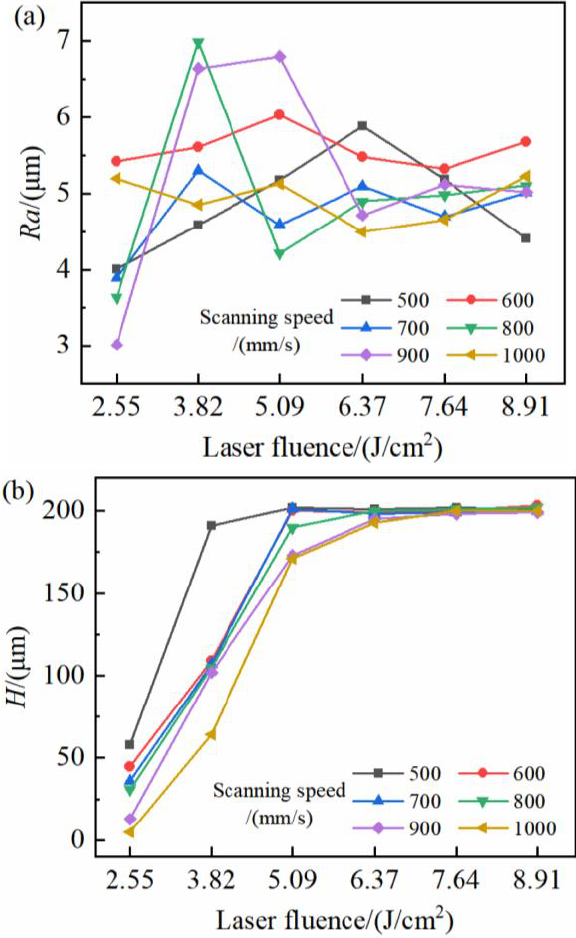
Figure 9. Cleaning effect of the samples after laser cleaning at different process parameters: ( a ) surface roughness, ( b ) stripping thickness.